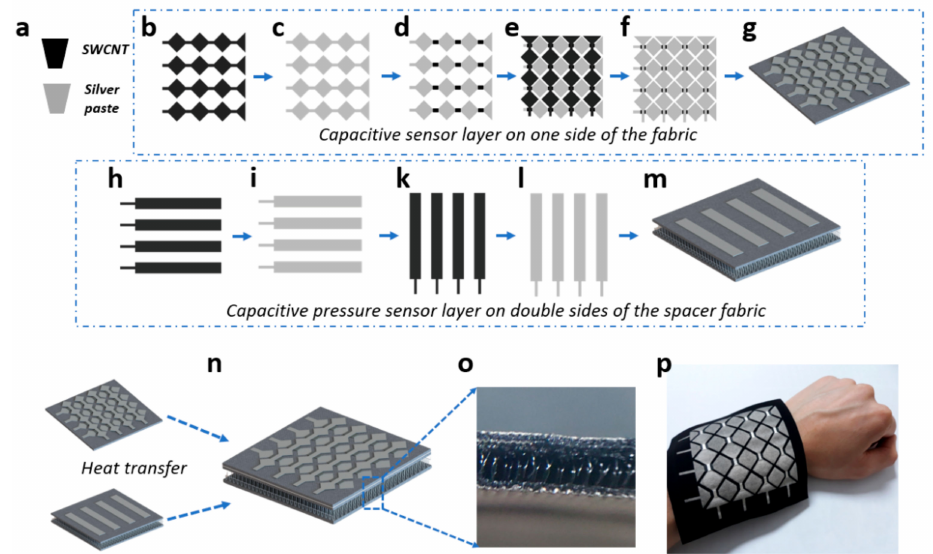
Figure 1. The manufacturing process of capacitive pressure sensor consisting of ( a ) preparing SWCNT ink and silver paste, ( b ) printing SWCNT rows of the capacitive sensor layer, ( c ) printing silver rows of the capacitive sensor layer, ( d ) printing the separation films at the cross-nodes of the capacitive sensor layer, ( e ) printing SWCNT columns of the capacitive sensor layer, ( f ) printing silver columns of the capacitive sensor layer, ( g ) the final capacitive sensor layer, ( h ) printing SWCNT rows on the top side of the capacitive-pressure sensor layer, ( i ) printing silver-rows on the top side of the capacitive-pressure sensor layer, ( k ) printing SWCNT columns on the bottom side of the capacitive-pressure sensor layer, ( l ) printing silver columns on the bottom side of the capacitive-pressure sensor layer, ( m ) the final capacitive-pressure sensor layer, ( n ) creating e-fabric-skin by combining the capacitive sensor layer and the capacitive-pressure sensor layer, ( o ) cross-section of the e-fabric-skin, and ( p ) application of the